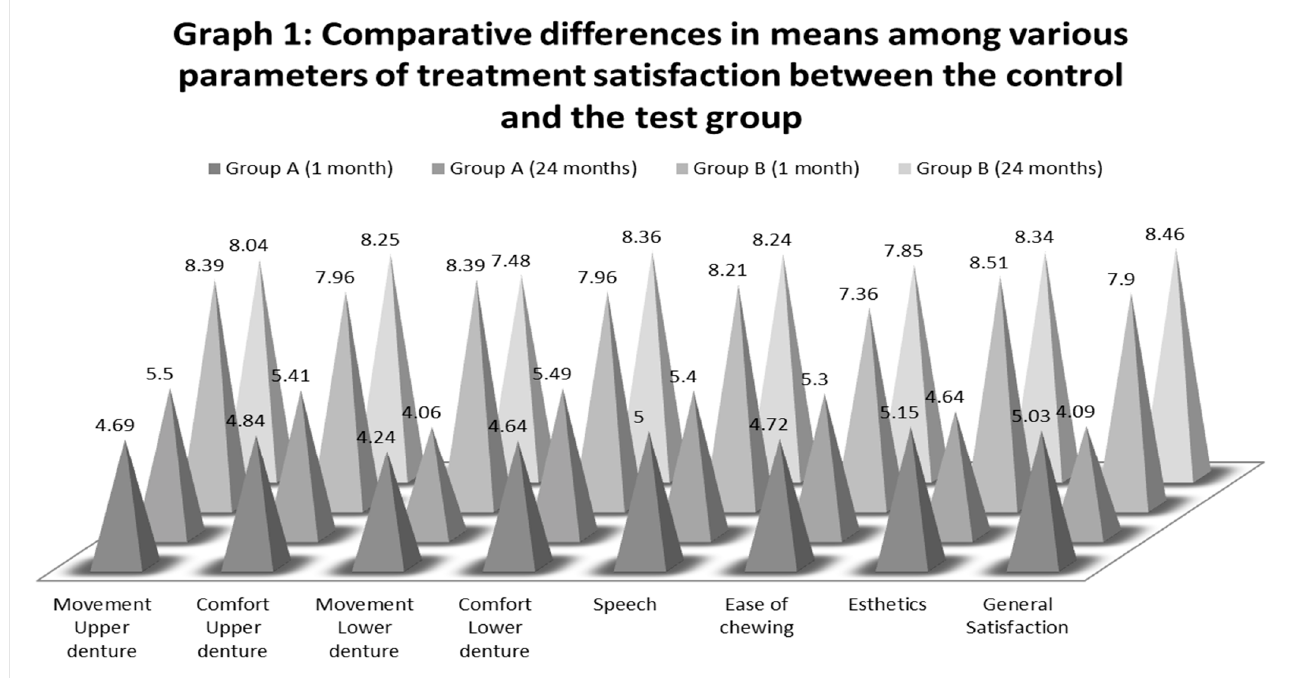
Figure 1. Graphical comparisons among various parameters of treatment satisfaction between the studied groups.